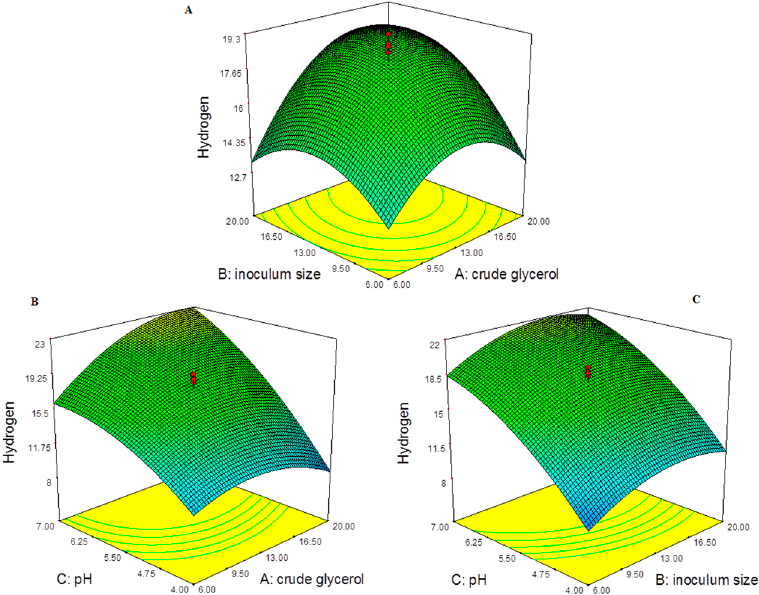
Figure 1. Hydrogen production (mmol/L) response across the input parameters: ( A ) across crude glycerol (g/L) and inoculum size (%); ( B ) across crude glycerol (g/L) and ( C ) inoculum size (%) and pH.